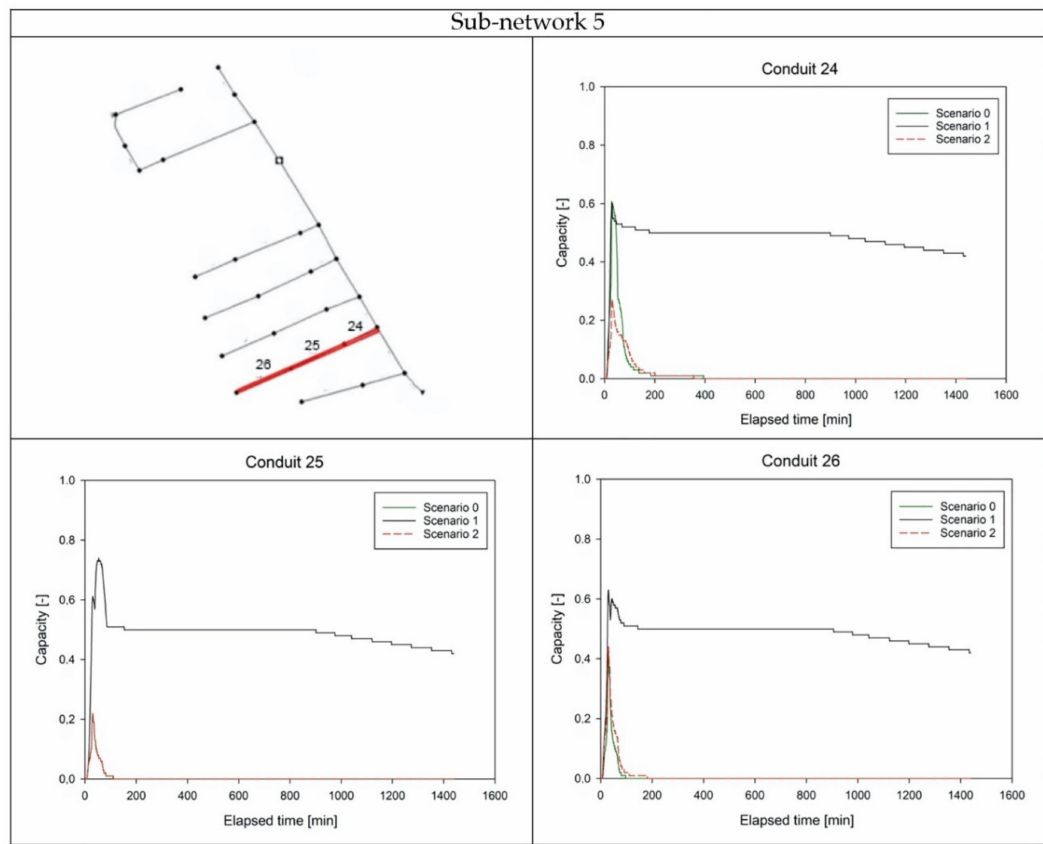
Figure A7. Conduits’ capacity in sub-network 5, highlighted in red in the first picture where the drainage network schematization is